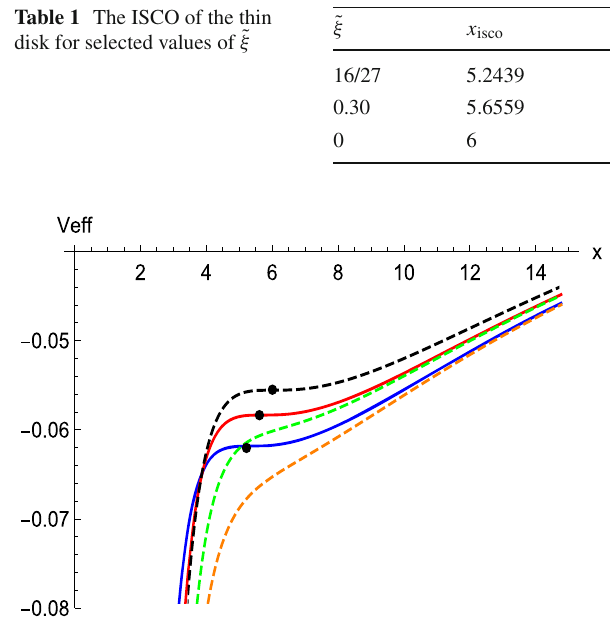
Fig. 2 The effective potential for the values of ¯ h = h / M when evalu- ated at the ISCO and for ˜ ξ = ˜ ξ c = 16 / 27 (solid blue curve), ˜ ξ = 0 . 3 (solid red curve) and for the classical case ˜ ξ = 0 (black dashed curve). The green and orange dashed lines shows the GR effective potential for the values of ¯ h corresponding to the RGI-black hole for the same values of ˜ ξ . The dots indicate the locations of the ISCO for each of those cases